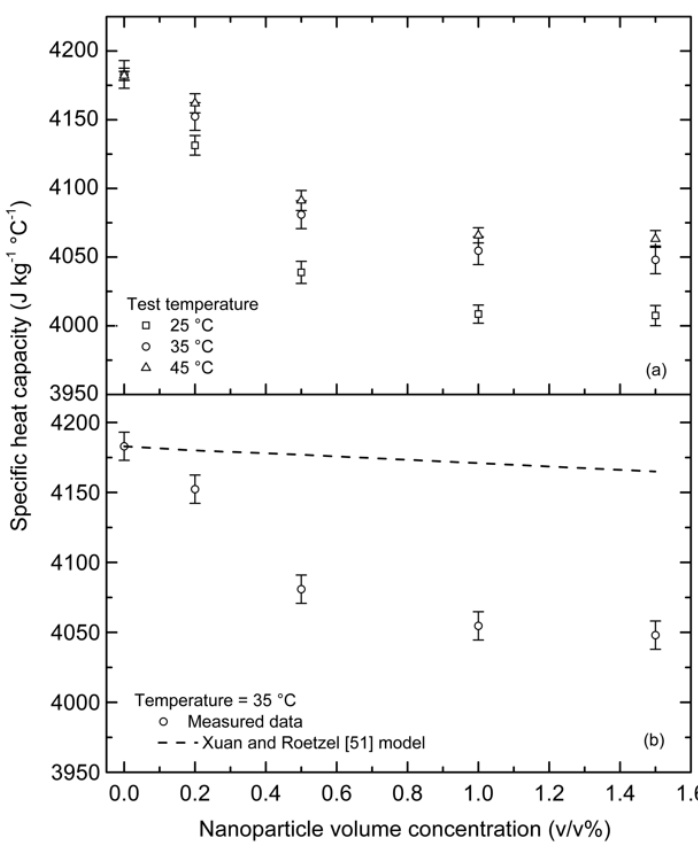
Figure 9. ( a ) Experimental specific heat of TiO 2 –W NFs as a function of temperature and NP volume concentration. ( b ) Comparison of the measured specific heat at 35 °C and that predicted by the Xuan and Roetzel [51] model.